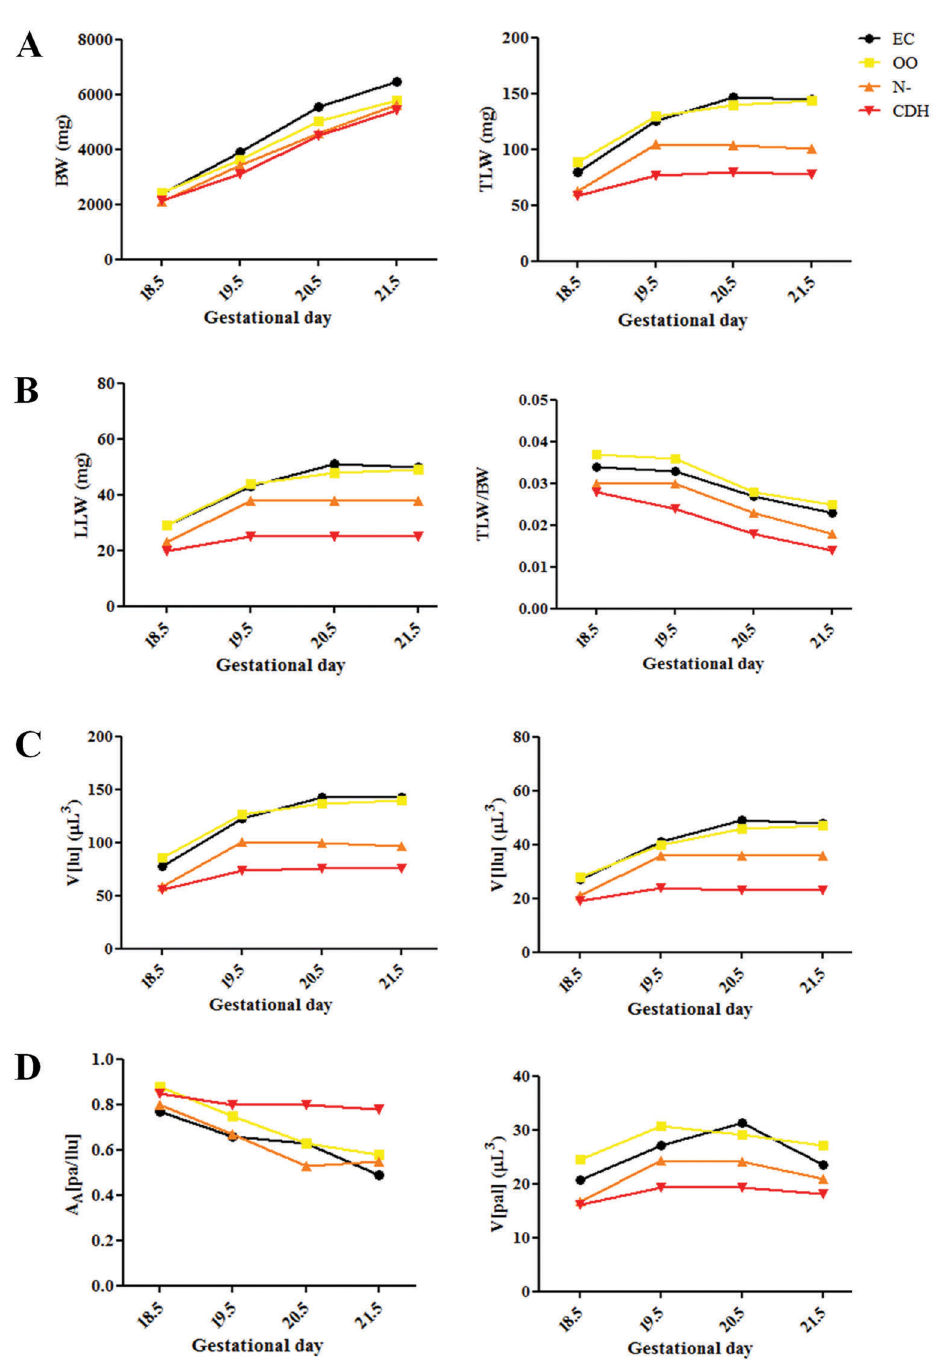
Figure 1. Evolution at 18.5, 19.5, 20.5, and 21.5 gestational days of: A , body weight (BW) and total lung weight (TLW); B , left lung weight (LLW) and TLW/BW ratio; C , total lung volume [V(lu)] and left lung volume [V(llu)]; D , left lung parenchymal area density [A A (pa/ llu)] and left lung parenchyma volume [V(pal)]. EC: external control; OO: exposed to olive oil; N-: exposed to nitrofen without CDH; CDH: exposed to nitrofen with